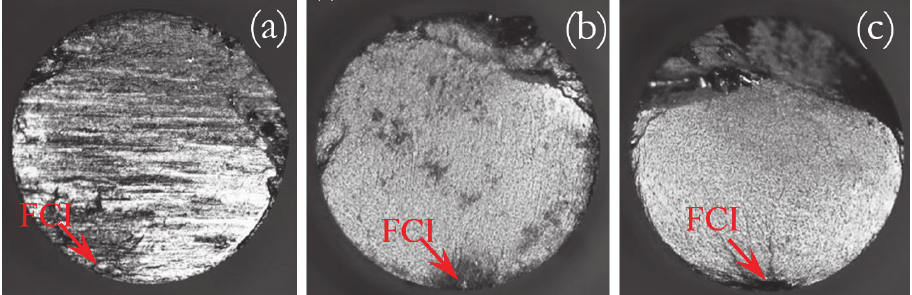
Figure 6: Stereoscopic microscope images showing an overall view of fatigue fracture surfaces of the samples tested at a total stress amplitude of 90 MPa (a) for the as-extruded sample, 120 MPa (b) and 125 MPa (c) for the forged sample. The red arrows indicate the crack initiation site. The fatigue cracks were initiated near the sample surfaces. FCI-fatigue crack